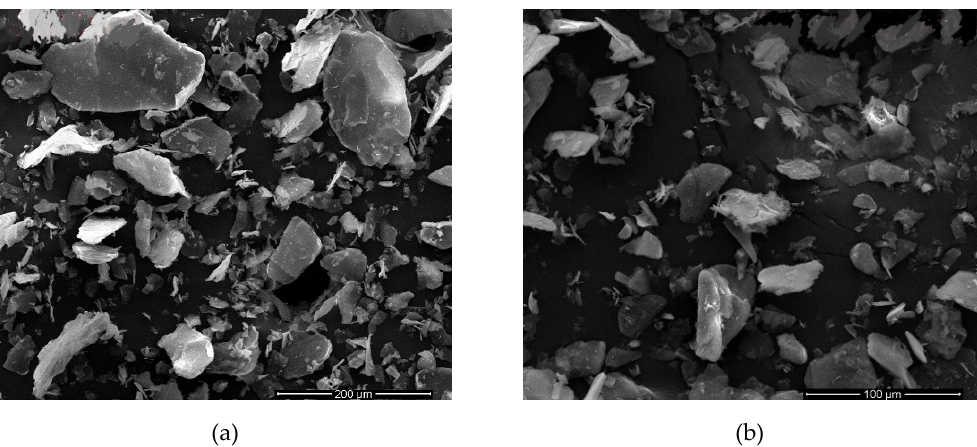
Figure 7. SEM images of the Mx 2 c 2 sample with a sonication time of 12 h with higher magnification ( a ) 500×; ( b ) 1000×.